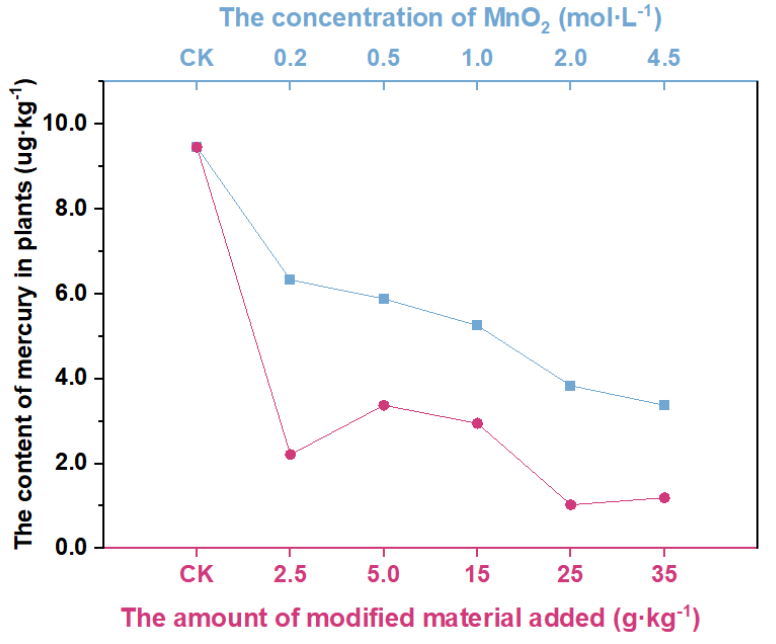
Figure 3. Mercury content of plants modified by different materials, and with different manganese dioxide concentrations. dioxide